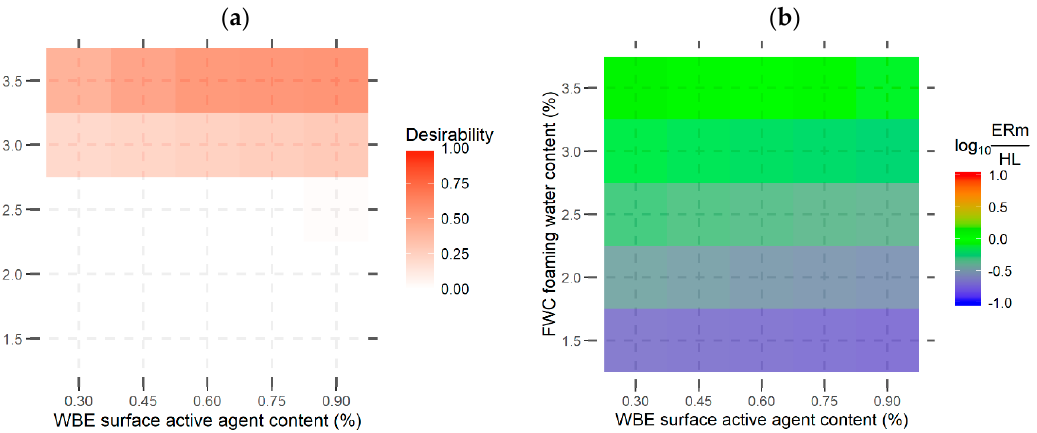
Figure 8. Evaluation of the foaming features of the 35 / 50 asphalt with the WBE additive: ( a ) desirability function, ( b ) the log 10 of the ratio of foam’s maximum expansion and half ‐ life.